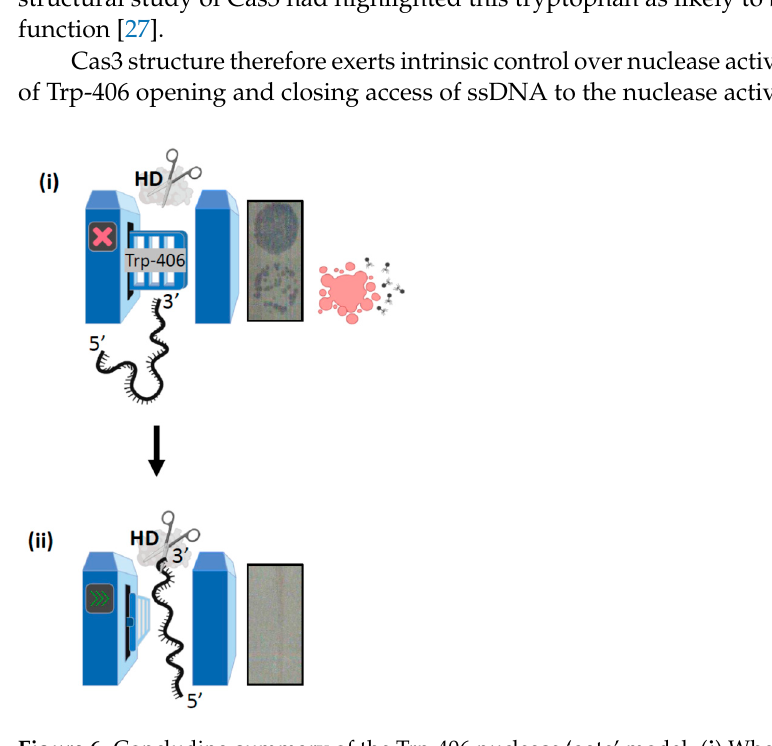
Figure 6. Concluding summary of the Trp-406 nuclease ‘gate’ model. ( i ) When Trp-406 is positioned close to helicase motif Ic it blocks the ssDNA binding channel to the nuclease (HD) active site, resulting in a ‘closed’ gate. In this scenario CRISPR interference is inhibited because MGE DNA is not destroyed, resulting in cell lysis evident as plaques on a bacterial lawn. ( ii ) Conformational movement of Cas3 re-positions Trp-406 proximally to Trp-230, with which it interacts to form a lining to ssDNA channel in the gate being ‘open’. In this state Cas3 is able to degrade MGE DNA to fulfil its role in CRISPR adaptation reactions.